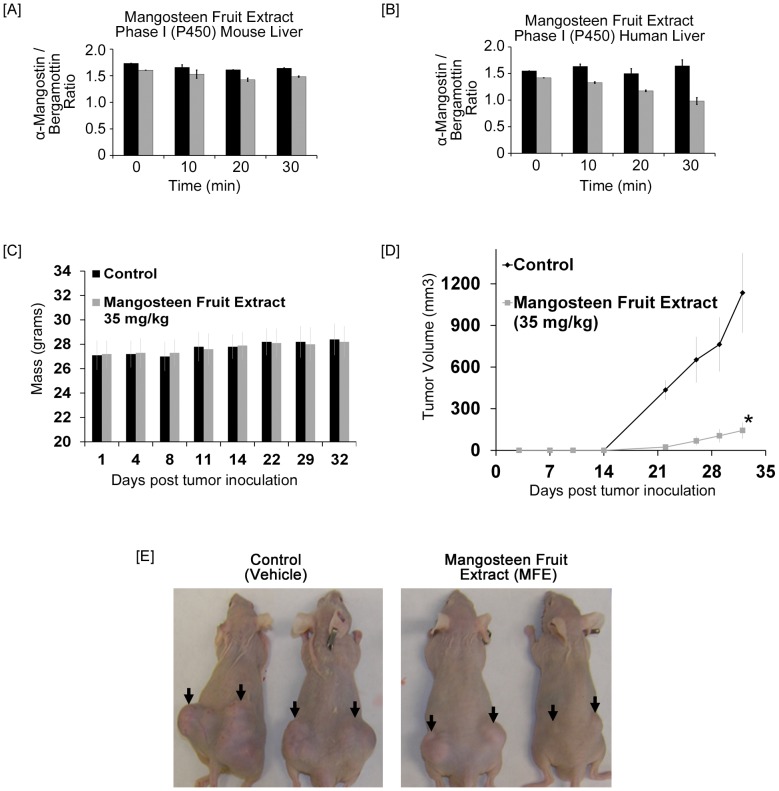
MFE was incubated with liver microsomes to mimic P450 Phase I metabolism in the mouse or human liver.Human and mouse liver microsomes were prepared as described in the materials and methods. Black bars represent the respective control for that individual time point. Gray bars represent the microsomal stability of α-Mangostin in Phase I enzyme system in both mouse and human liver microsomes. A ‘no preincubation’ was performed (data not shown) and did not have any impact on the interpretation of this data. [A], Mangosteen Fruit Extract (standardized to α-Mangostin) was incubated with mouse liver microsomes. [B], Mangosteen Fruit Extract (standardized to α-Mangostin) was incubated with human liver microsomes. [C], Twelve animals were subcutaneously injected in each flank of the mouse (i.e. two tumors per mice) with ∼1×106 22Rv1 cells to initiate tumor growth. Twenty-four hours after cell implantation, the animals in each cohort received by intraperitoneal administration vehicle or mangosteen fruit extract (35 mg/kg). Body weights of athymic nude mice treated with control vehicle or mangosteen fruit extract (35 mg/kg) intraperitoneally twice per week were measured two times weekly. [D], The average tumor volume of control and mangosteen fruit extract treated mice were plotted over days after tumor cell inoculation. Data points represent the mean of 12 tumors from six mice; bars represent standard deviation of the mean, *P<0.01. [E], Representatives of tumor bearing mice from control and MFE-treated group.